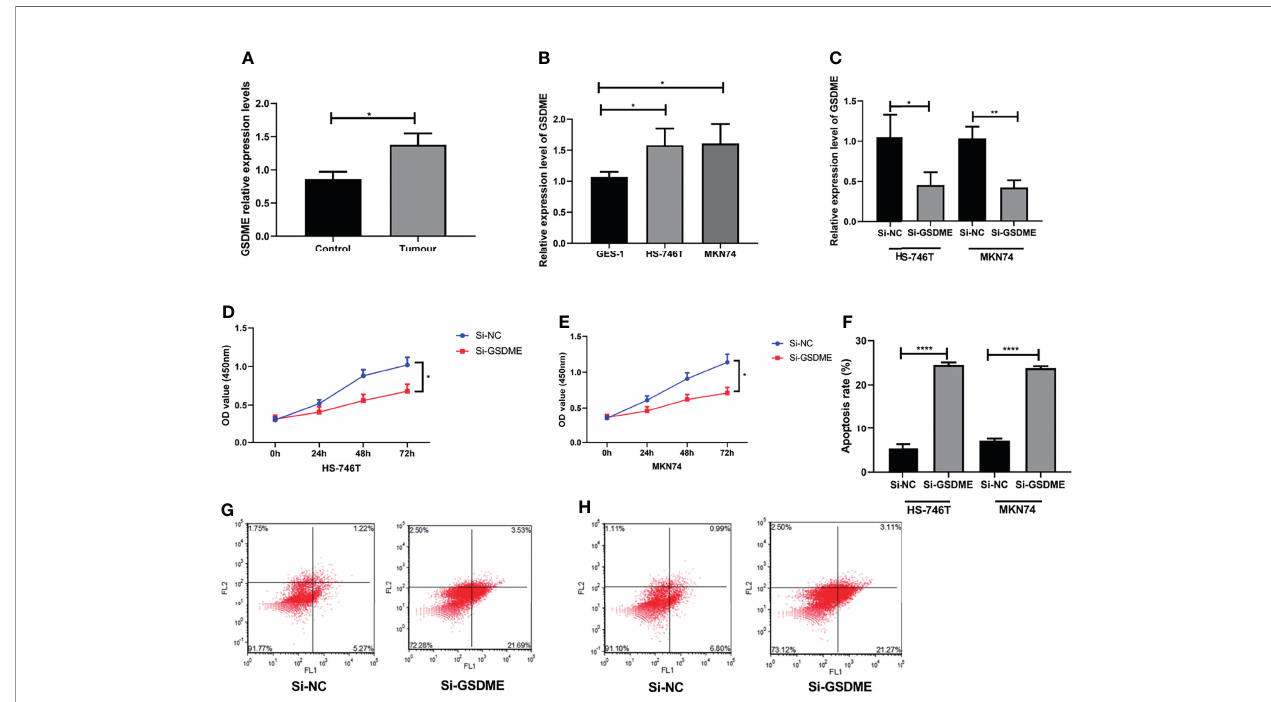
FIGURE 7 | Effect of the knockdown of GSDME expression on gastric cancer cells. (A) . Relative expression levels of GSDME in gastric cancer and adjacent to paracancerous tissues. (B) Expression of GSDME in human gastric cancer cell lines HS-746T and MKN74 and gastric mucosal cells GES-1. (C) Transfection ef fi ciency. (D) Effect of reduced GSDME levels on the proliferation of HS-746T cells. (E) Effect of reduced GSDME levels on the proliferation of MKN74 cells. (F) Promotion of apoptosis after GSDME levels were reduced. (G) Flow apoptosis diagram based on HS-746T cells. (H) Flow apoptosis diagram based on MKN74 cells. *P < 0.05, **P < 0.01, ****P <